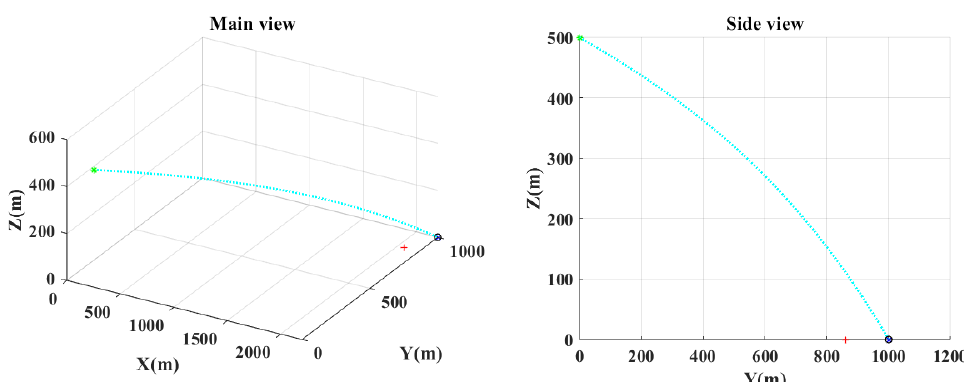
Figure 9. The ballistic of IPSO in case